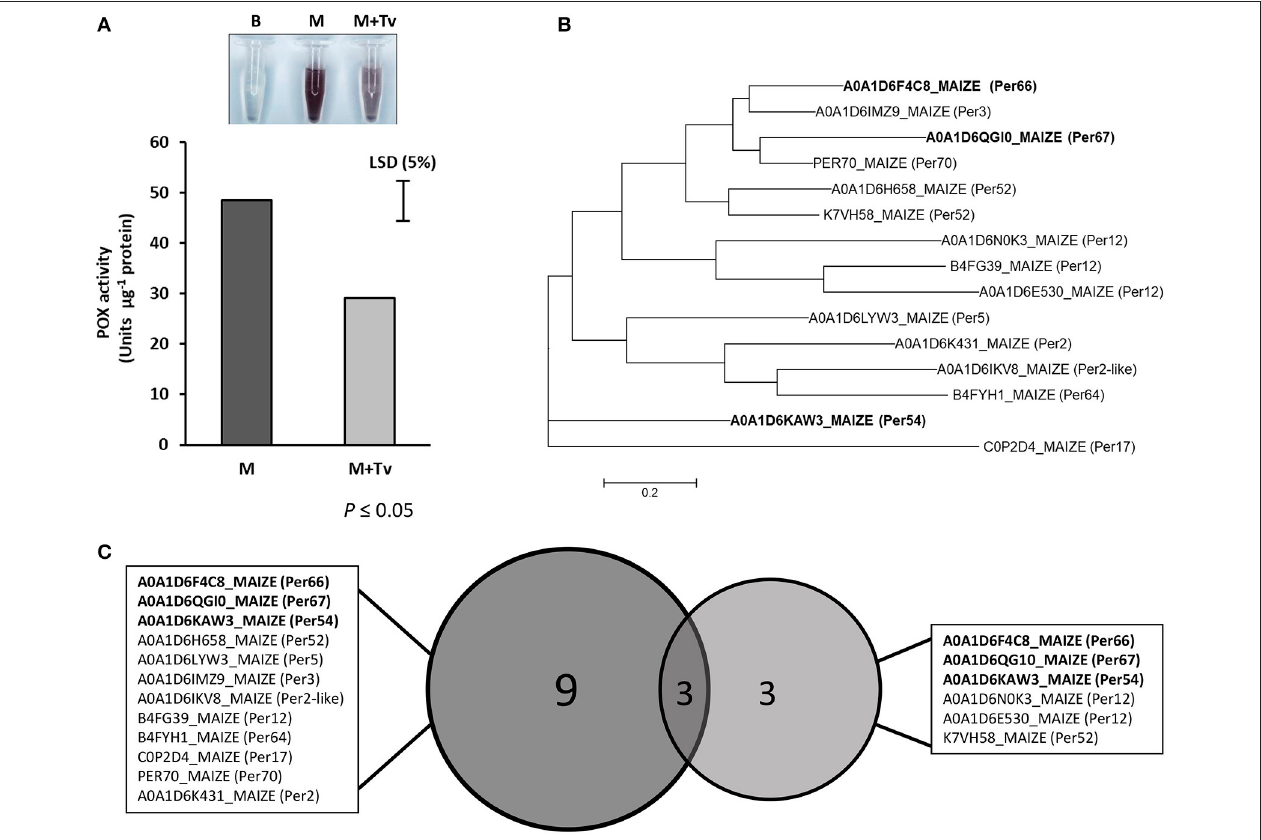
FIGURE 5 | Peroxidase study during T. virens -maize interaction. (A) Peroxidase activity in un-inoculated (M) and inoculated (M + Tv) maize roots with T. virens after 5 days interaction ( p ≤ 0.05). (B) Phylogenetic tree of peroxidases identified in the maize apoplast zone. Using Muscle, the composite proteins were aligned, and the Maximum likelihood tree, were generated in Mega 6. (C) Comparison between peroxidases expressed in maize roots with or without T. virens . Bold names represent peroxidases that were present in both